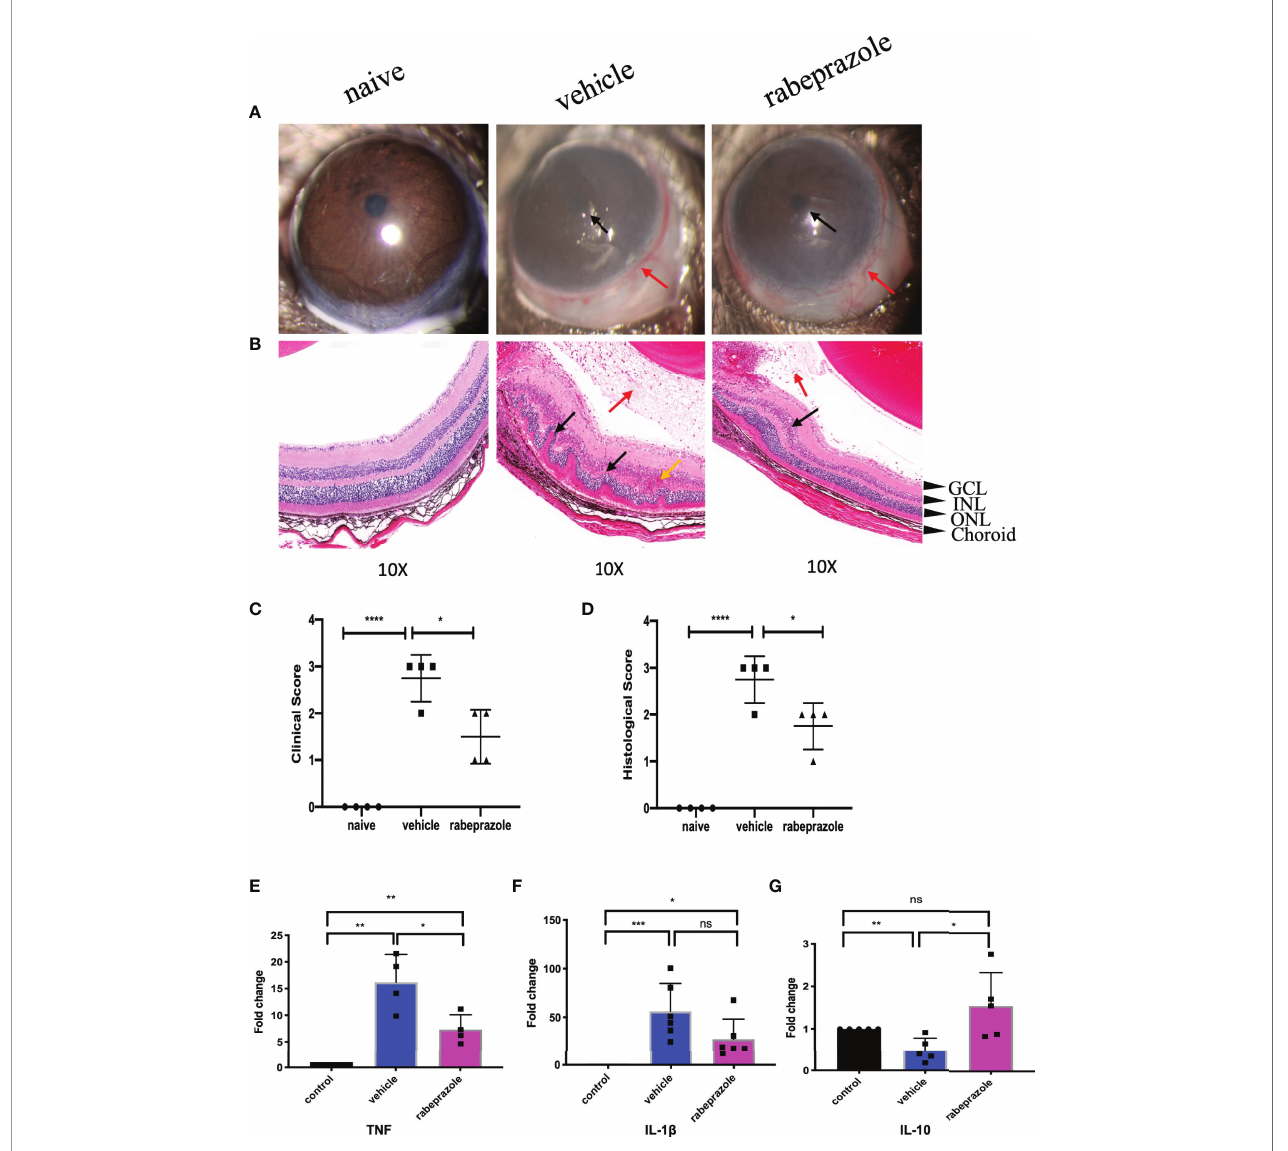
FIGURE 9 | Rabeprazole alleviated EAU and inhibited TNF and IL-1 b and promoted the expression of IL-10 in the retinas of EAU. (A) Representative slit-lamp photographs of the naive group, the vehicle intervention group, and the rabeprazole intervention group on day 14 (n = 4/group). Red arrow, conjunctival hyperemia. Black arrow, posterior synechiae, and in fl ammatory exudation. (B) Representative staining images of HE sections in the naive group, the vehicle intervention group, and the rabeprazole intervention group on day 14 (n = 4/group). Red arrow, vitreous in fl ammatory cell in fi ltration. Black arrow, retinal fold. Yellow arrow, neovascularization, and hemorrhage (GCL, ganglion cell layer; INL, inner nuclear layer; ONL, outer nuclear layer). (C) The clinical score of the naive group, the vehicle intervention group, and the rabeprazole intervention group on day 14 (n = 4/group). (D) The histopathological score of the naive group, the vehicle intervention group, and the rabeprazole intervention group (n = 4/group). (E) qRT-PCR analysis of TNF in retinas of the naive group, the vehicle intervention group, and the rabeprazole intervention group on day 14 (n = 4/group). (F) qRT-PCR analysis of IL-1 b in retinas of the naive group, the vehicle intervention group, and the celastrol intervention group on day 14 (n = 6/group). (G) qRT-PCR analysis of IL-10 in retinas of the naive group, the vehicle intervention group and the rabeprazole intervention group on day 14 (n = 5/group) * P < 0.05; ** P < 0.01; *** P < 0.001; ****P < 0.0001 (two-tailed student ’ s t -test). Graphs show mean ±